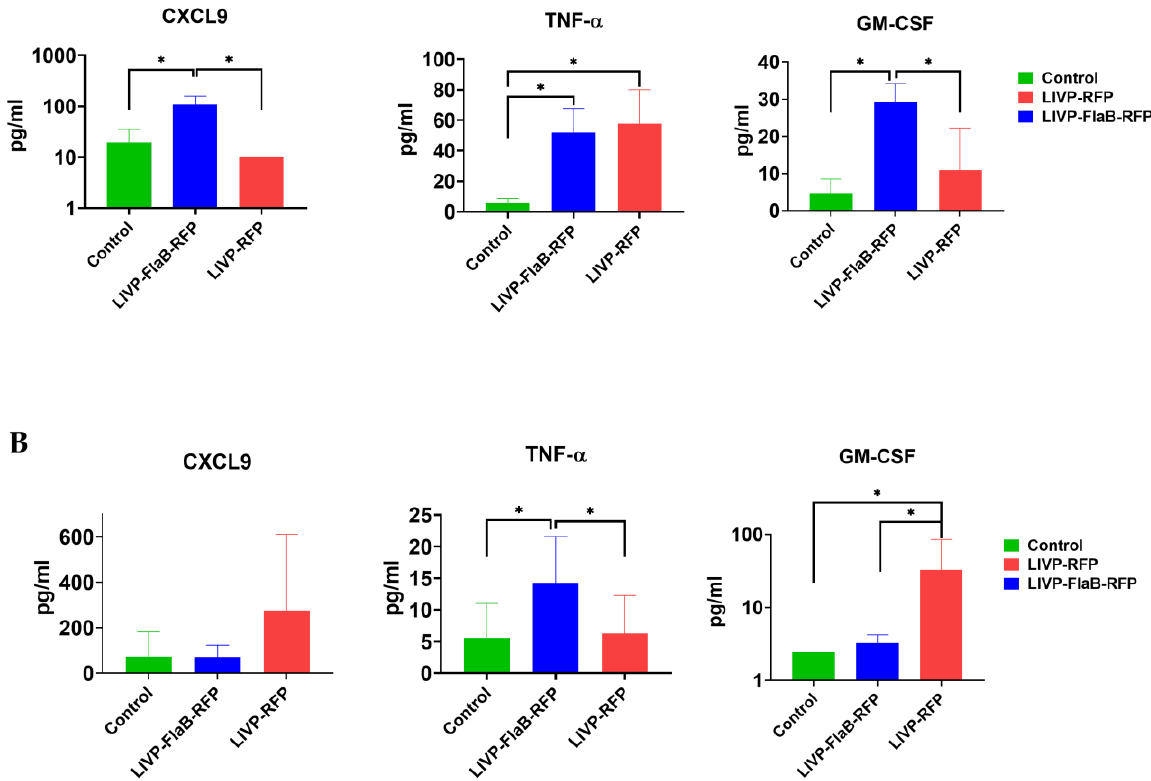
Figure 8. Cytokine analysis. ( A ) Cytokine analysis of the tumor-infiltrated fluids (TIFs) and ( B ) serum samples from the B16 melanoma models treated by LIVP-RFP or LIVP-FlaB-RFP compared with the untreated mice (control group). For statistical analysis, ANOVA was performed; * p < 0.05 indicates significance.